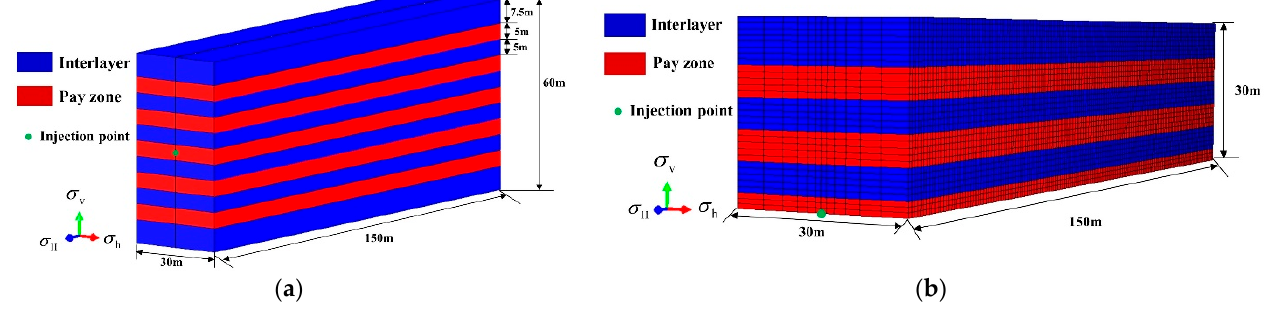
Figure 1. Model establishment: ( a ) geometry model; ( b ) finite element model. Table 1. The base input parameters for the model.